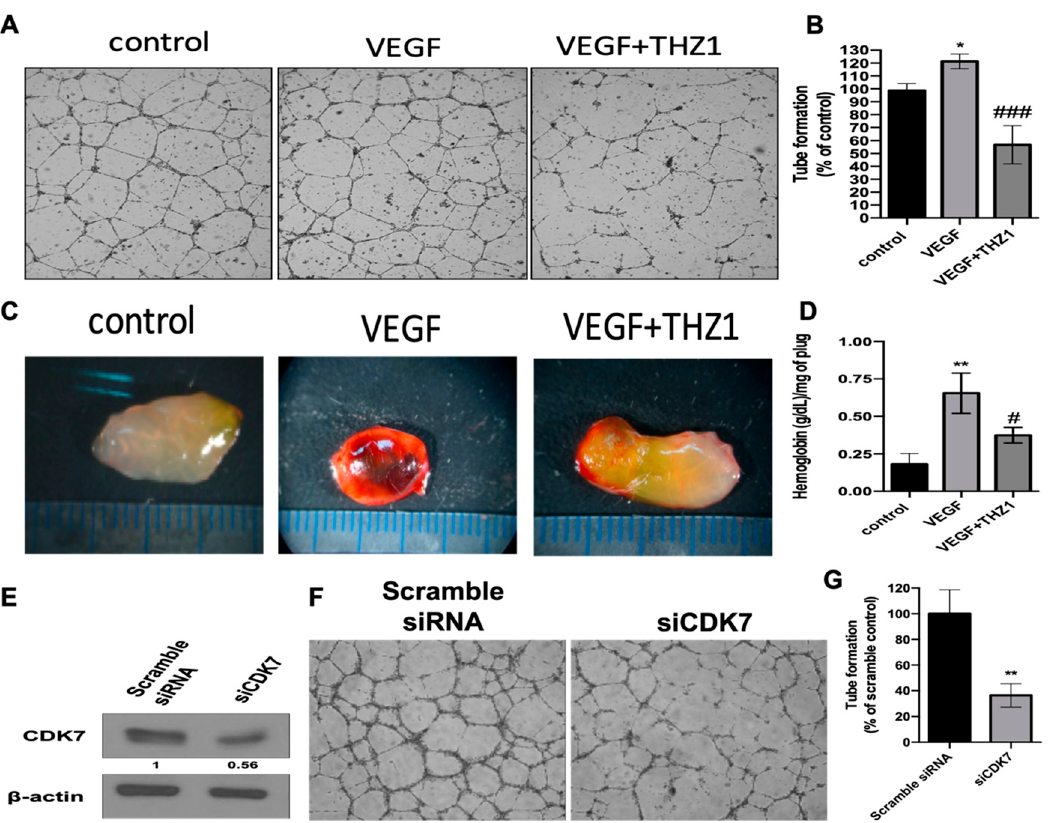
Figure 4. THZ1-induced CDK7 inhibition or CDK7 knockdown suppressed angiogenesis in vitro and in vivo. ( A , B ) THZ1 reduced VEGF-activated capillary-like tube formation in HUVECs. HUVECs were plated on Matrigel-coated wells and then treated with VEGF (10 ng / mL) in the presence or absence of THZ1 (250 nM). After 16–24 h incubation, HUVEC’s tube formation on Matrigel was photographed ( A ) and further quantified by counting tube density ( B ). * p < 0.05 compared to the control group (DMSO); ### p < 0.001 compared to the VEGF (10 ng / mL)-treated group. ( C , D ) THZ1 diminished VEGF-activated angiogenesis in the in vivo Matrigel plug assay. Matrigel (500 µ L) containing VEGF (100 ng) or VEGF (100 ng) plus THZ1 (500 nM) was subcutaneously injected into the ventral area of six-week-old FVB mice ( n = 3). After 5 days, Matrigel plugs were excised and photographed ( C ). Furthermore, hemoglobin content of recovered Matrigel plugs was determined ( D ). ** p < 0.01 compared to the control group (DMSO); # p < 0.05 compared to the VEGF (10 ng / mL)-treated group. ( E – G ) siCDK7 decreased CDK7 expression and angiogenic tube forming activity in HUVECs. HUVECs were transfected with scrambled or CDK7-specific siRNAs (siCDK7; cdk-466) for 24 h. The cells were then harvested and subjected to Western blotting analysis for checking CKD7 expression ( E ). Numbers under the plots indicate the fold change of protein level relative to their control. Further, the transfected cells were seeded onto a Matrigel for verifying and quantifying the activity of tube formation ( F , G ). ** p < 0.01 compared to the scramble siRNA control group. Similar results were obtained in two independent experiments.